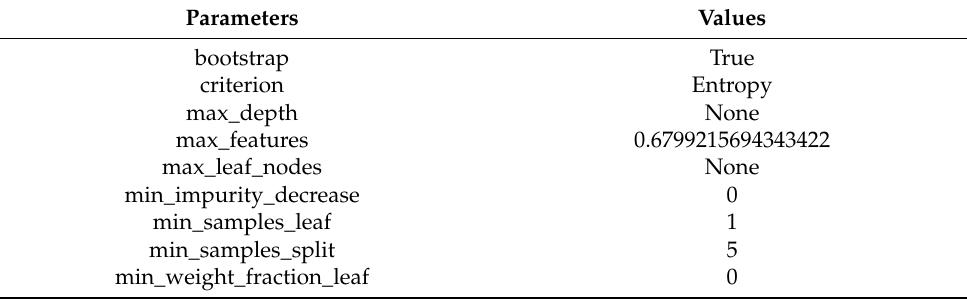
Table 9. Parameters used for the random forest classification